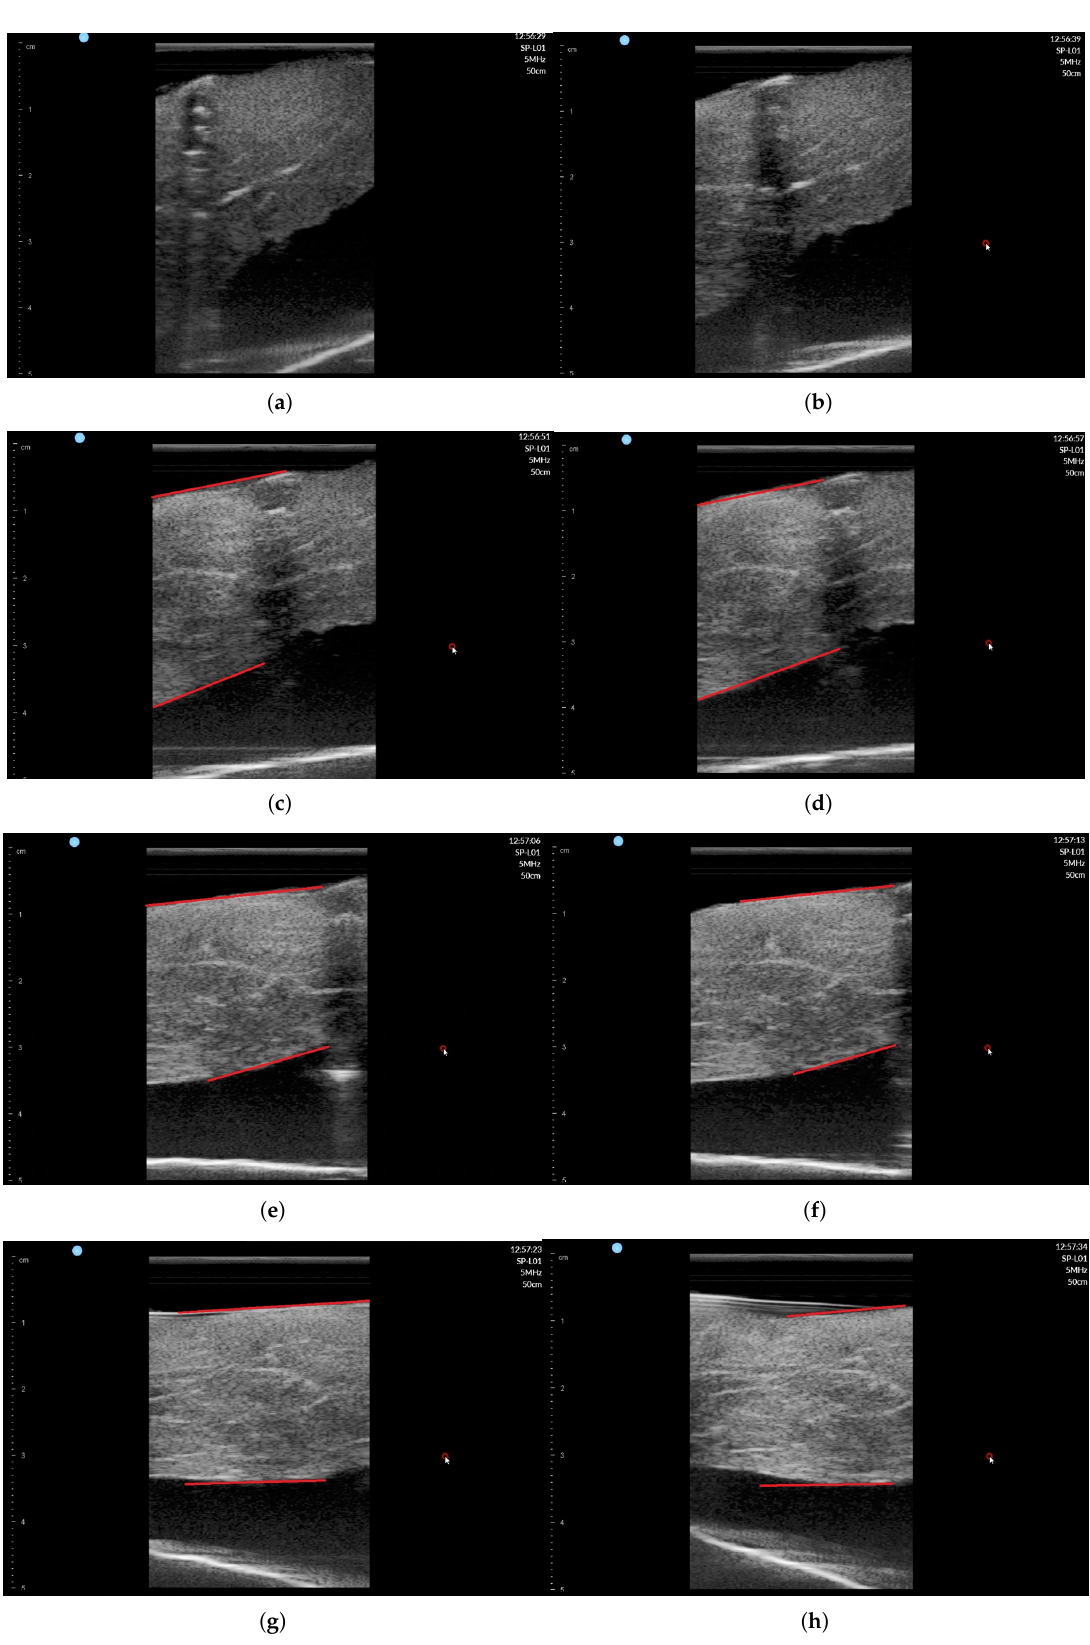
Figure 18. Phantom ultrasound scanning sequences with operator #1 measurement. ( a ) θ = 50 ◦ . ( b ) θ = 60 ◦ . ( c ) θ = 70 ◦ . ( d ) θ = 80 ◦ . ( e ) θ = 90 ◦ . ( f ) θ = 100 ◦ . ( g ) θ = 110 ◦ . ( h ) θ = 120 ◦